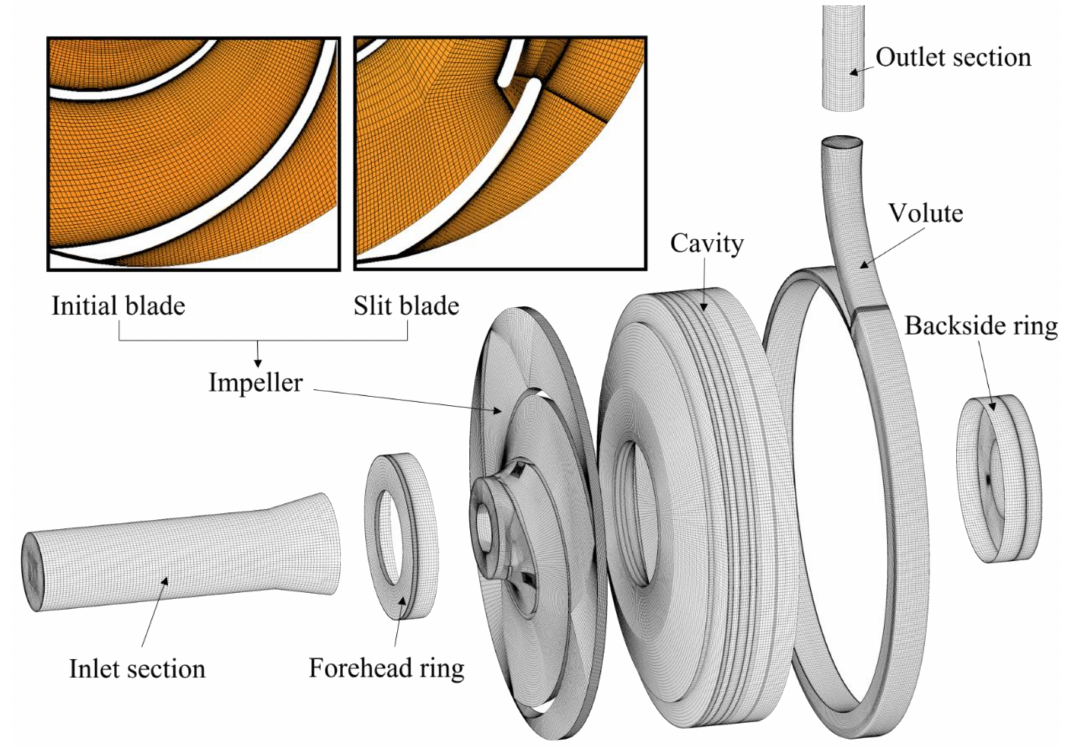
Figure 2. Calculated domain and grid